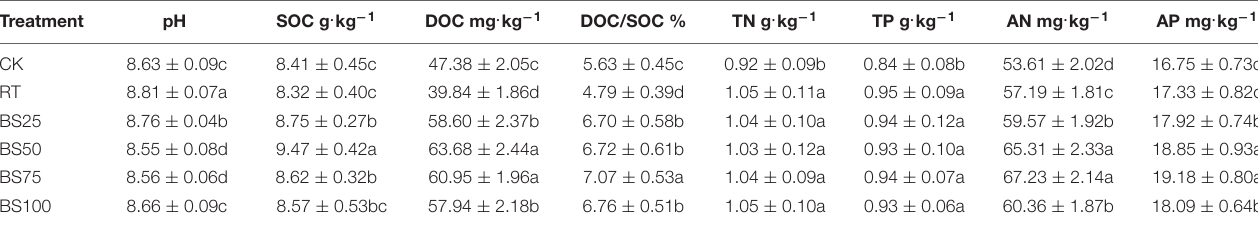
TABLE 2 | Soil properties associated with the rice harvest after 5 years of treatment application.